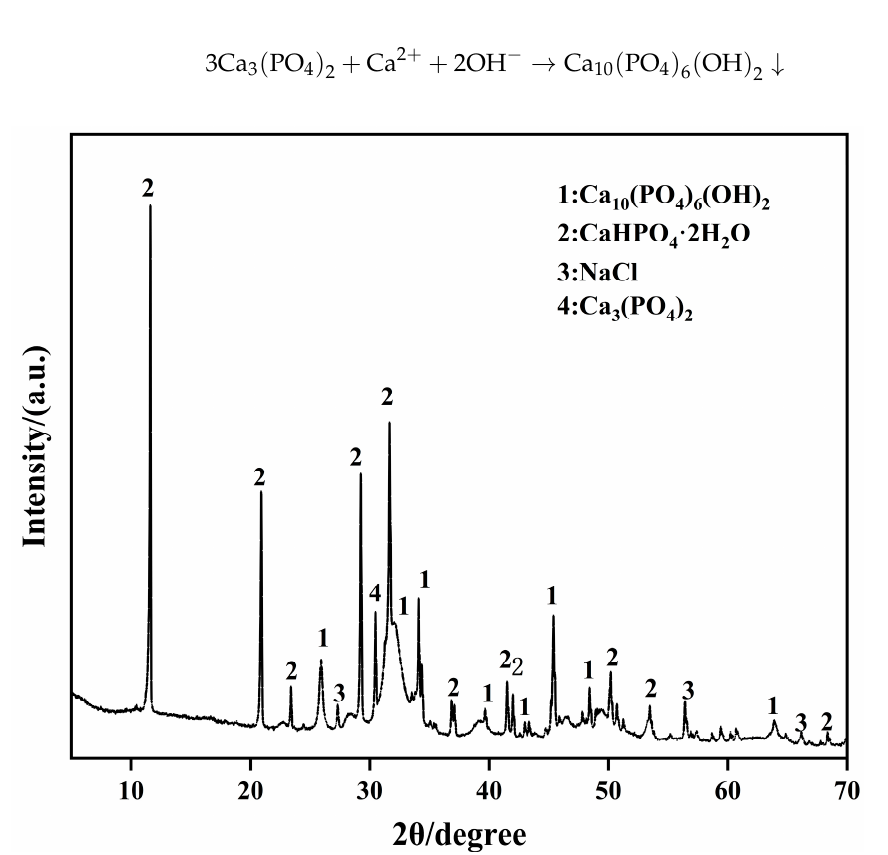
Figure 3. XRD pa tt erns of the precipitations on the wood surface. Figure 3. XRD patterns of the precipitations on the wood